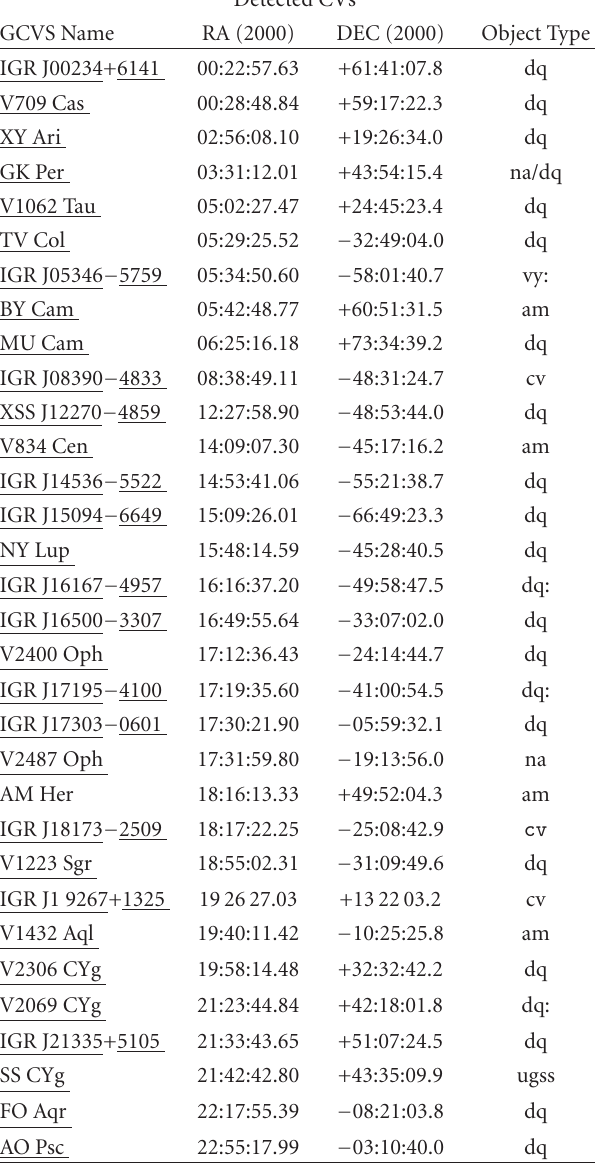
Table 1: Cataclysmic variables detected in hard X-rays by INTE- GRAL